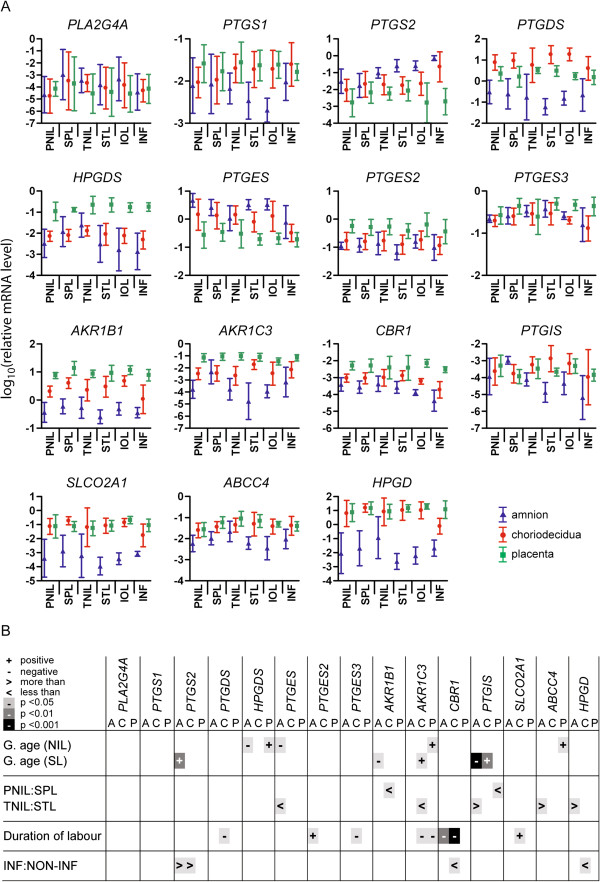
Expression of prostaglandin pathway genes in pregnant human uterine tissues. (A) Relative levels of mRNA by ΔΔCt method following qPCR, log10-transformed, shown as mean ± SD. A, amnion (blue); C, choriodecidua (red); P, placenta (green). PNIL, preterm not-in-labour; SPL, spontaneous preterm labour; TNIL, term not-in-labour; STL, spontaneous term labour; IOL, induction of labour; INF, inflammation. Numbers of samples: PNIL = 4; SPL = 4; TNIL = 6; STL = 5; IOL = 5; INF = 4. (B) Statistical comparisons of gene expression. Relationships with gestational age (g. age) in combined not-in-labour (NIL = PNIL + TNIL) and spontaneous labour (SL = SPL + STL) groups, and with duration of labour (SPL + STL + IOL) tested by correlation (Pearson’s); level of significance and direction of correlation are indicated. Comparisons between the presence and absence of labour (preterm and term) and inflammation were tested by Student’s t-tests.